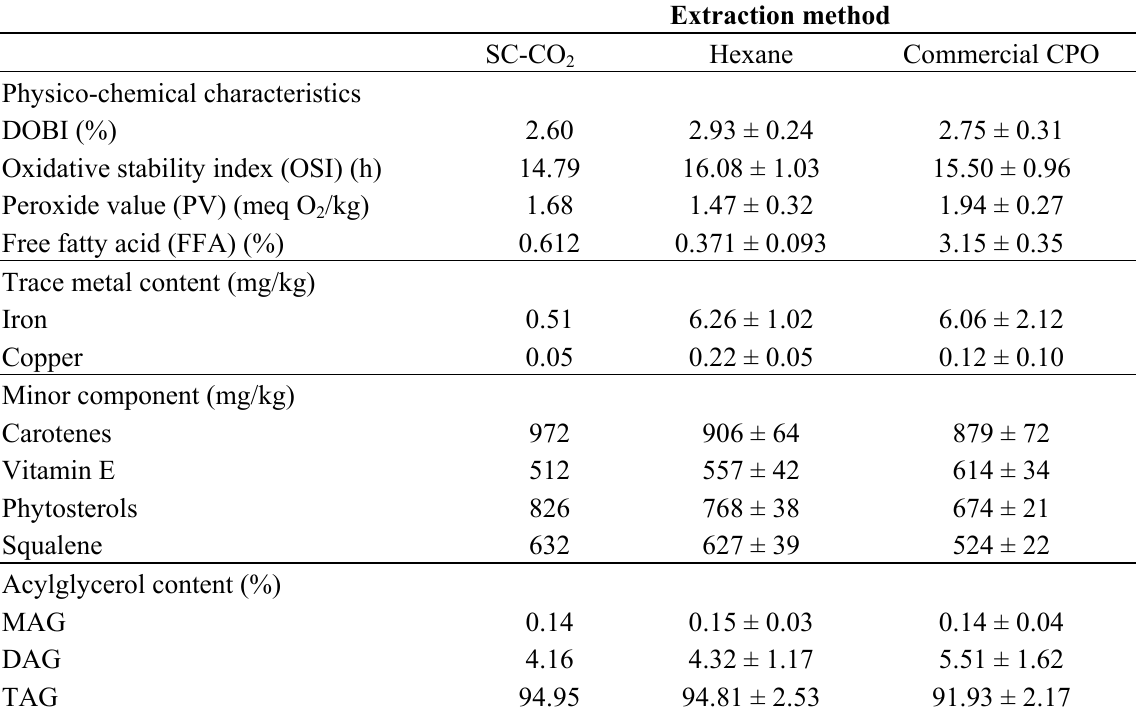
Table 6. The physico-chemical characteristics, trace metals, minor components and acylglycerol contents in the SC-CO , hexane and commercial extracted palm oil. 2 Reproduced with substantial modification from